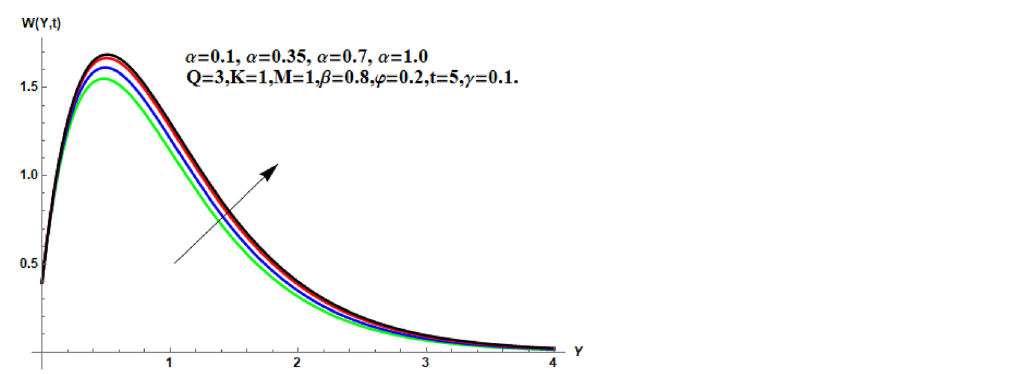
Figure 7. Velocity profile for different values of α